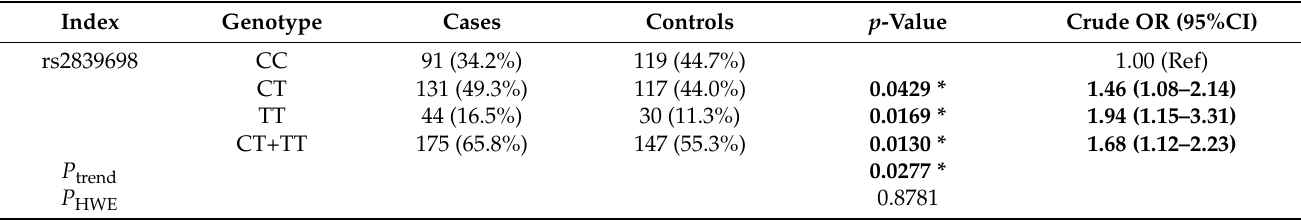
Table 2. Distributions of H19 rs2839698 genotypes between childhood leukemia and control groups.